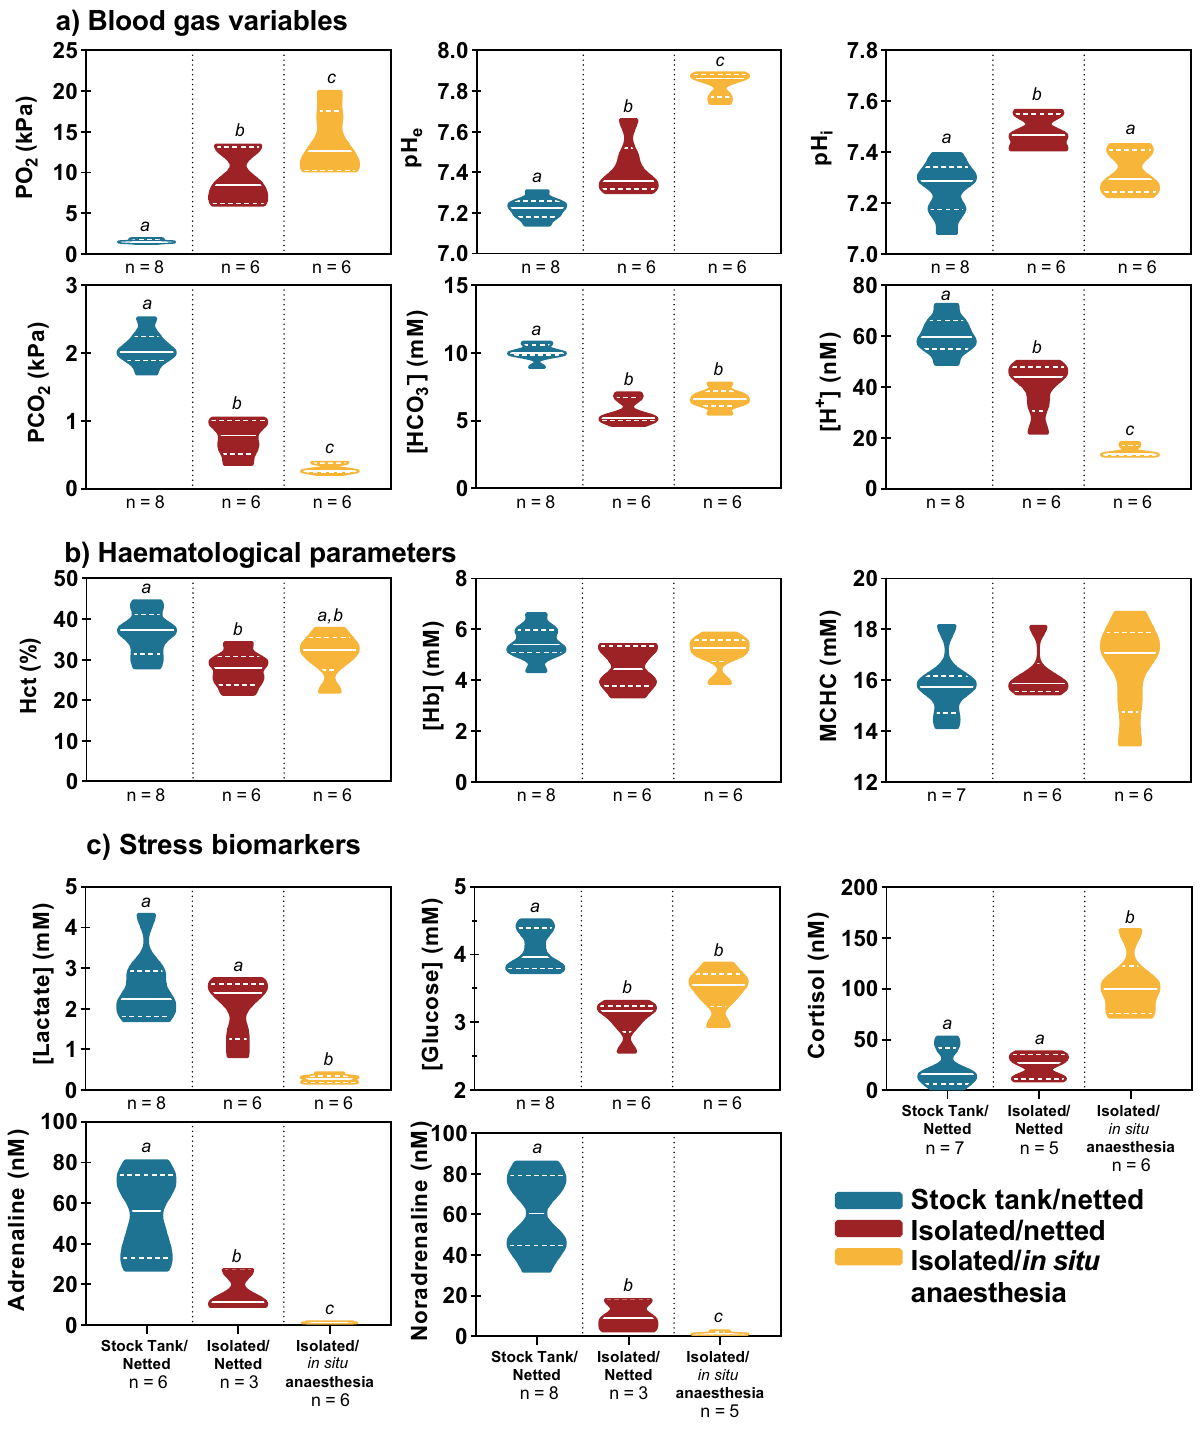
Figure 2. Experiment 1 ( a ) Effect of sampling method on blood gas variables (blood PO 2 , blood pH e , RBC pH i , blood pCO 2 , plasma bicarbonate concentration, plasma H + concentration. ( b ) Effect of sampling method on haematological parameters (Haematocrit, haemoglobin concentration & mean corpuscular haemoglobin concentration). ( c ) Effect of sampling method on stress biomarkers (plasma lactate concentration, plasma glucose concentration, plasma cortisol concentration, plasma adrenaline concentration, plasma norepinephrine concentration). Data presented as truncated violin plots with a solid white line denoting the median and dotted white lines indicating the bounds of the inter-quartile range (IQR) and the width of the bar estimating the density of data points using kernel density estimation. Significant differences are denoted by different letters as determined by ordinary one-way ANOVA with Tukey’s multiple comparisons and alpha defined as